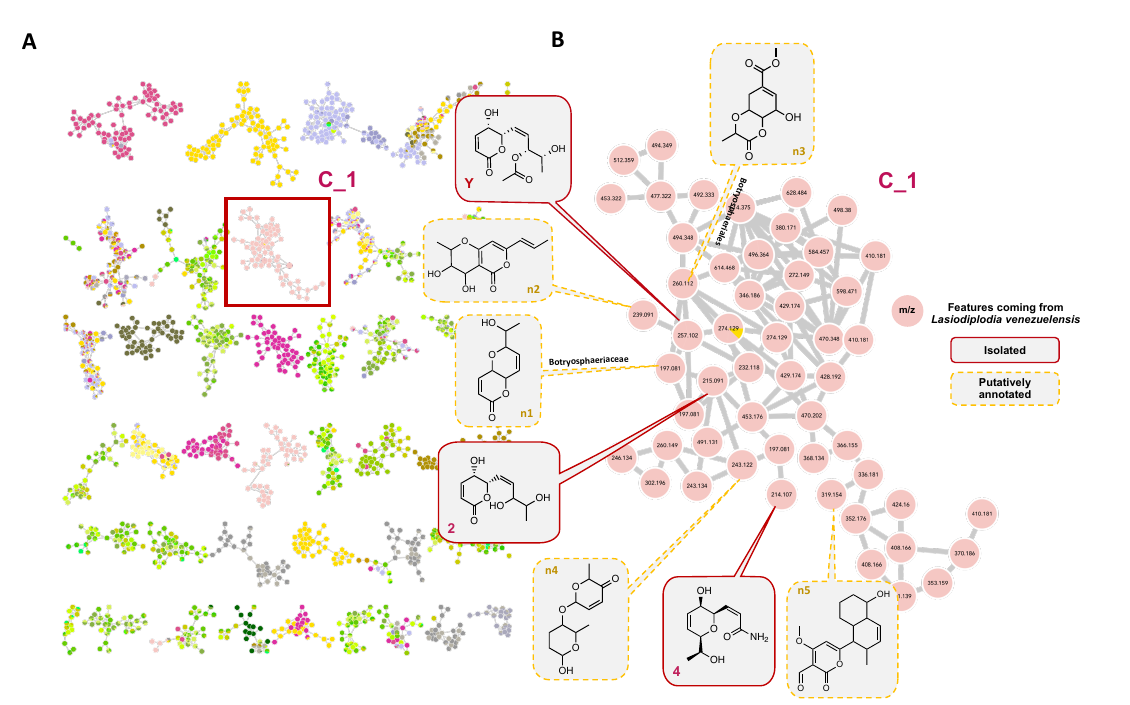
Figure 4. ( A ) Global molecular network of the 15 endophytic fungal extracts. Colors of the nodes correspond to the different strains present in the collection, with Cluster C_1 containing pyranone derivatives highlighted with a red square. ( B ) Cluster C_1, unique to the Lasiodiplodia venezuelensis strain, with annotated nodes (with the active compounds 2 and 4, and the previously isolated analog